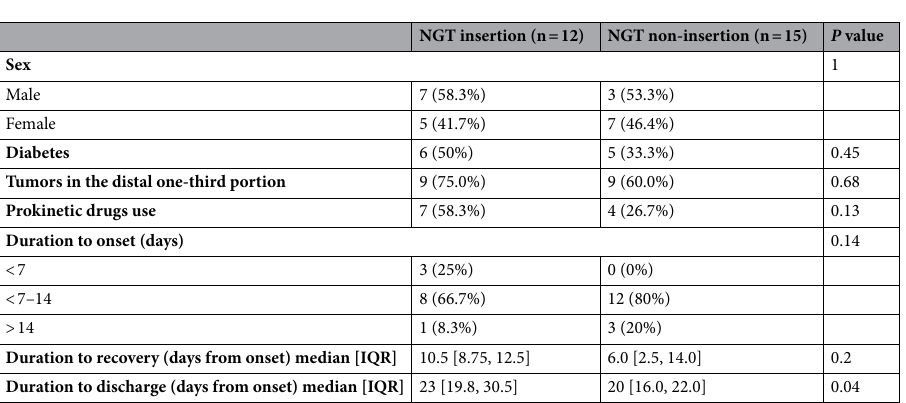
Table 4. Severity and clinical features of delayed gastric emptying. NGT nasogastric tube, IQR interquartile